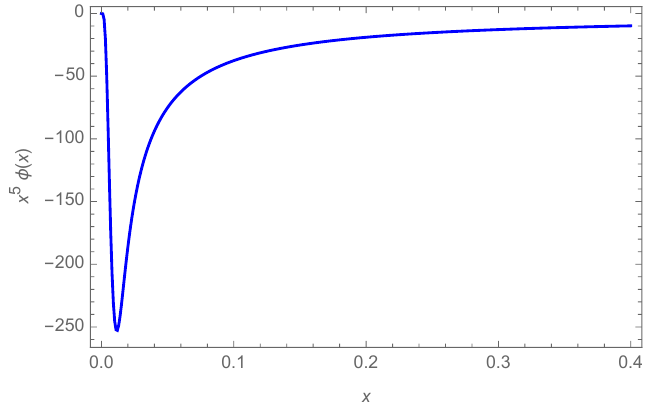
Figure 4. Dimensionless function φ as a function of x = a